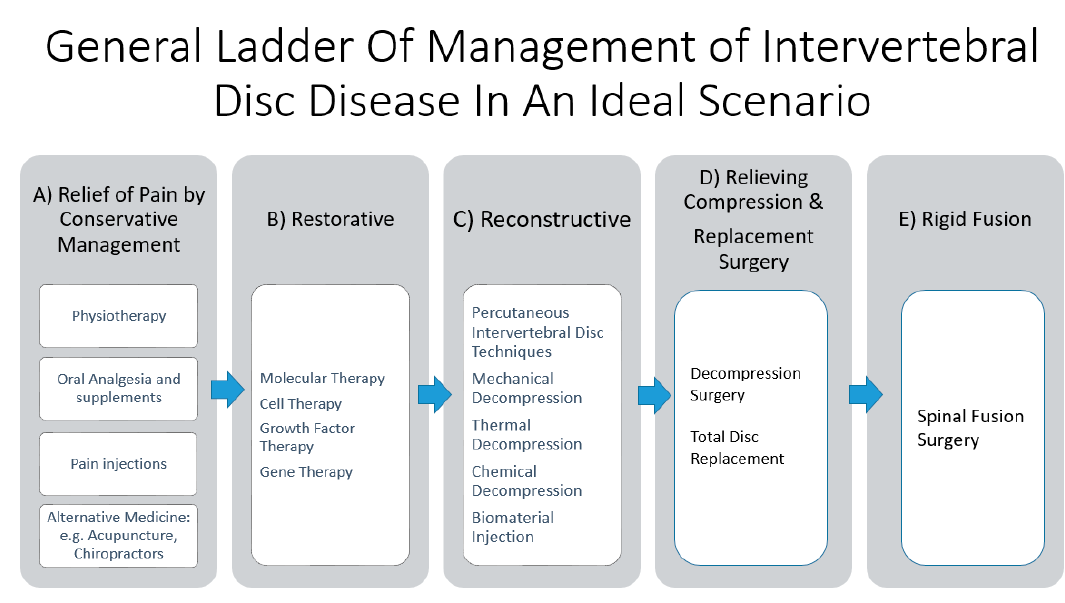
Figure 1. General ladder of management of intervertebral disc disease in an ideal scenario. ( A ) Relief of pain by conservative management comprises of physiotherapy, oral analgesia, and nutrition